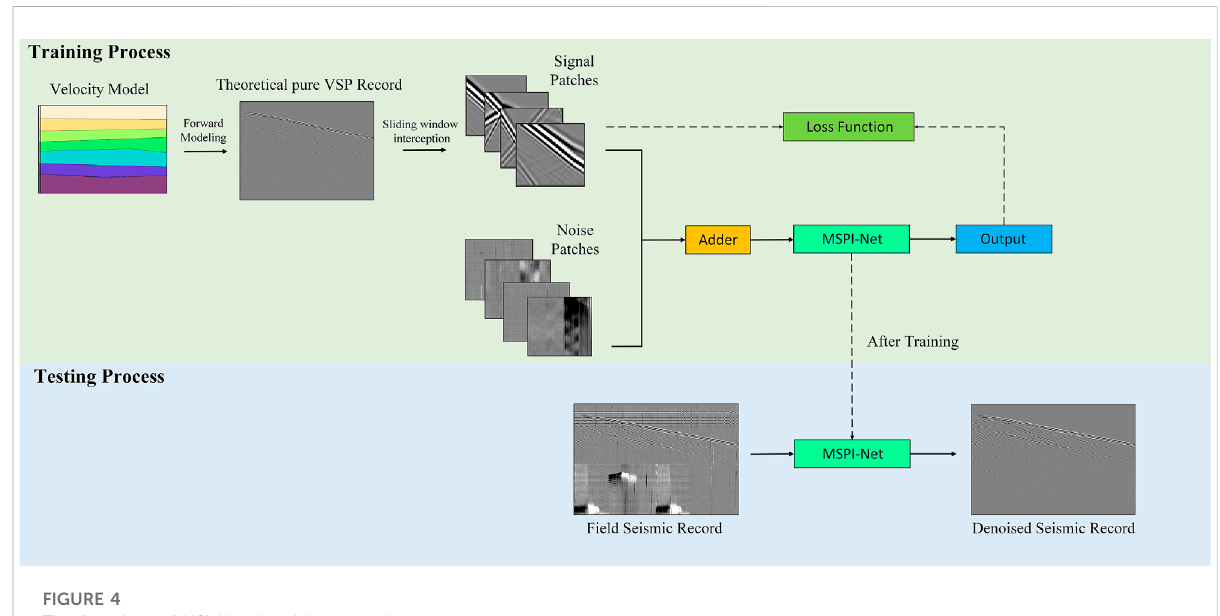
FIGURE 4 The fl owchart of MSI-Net denoising